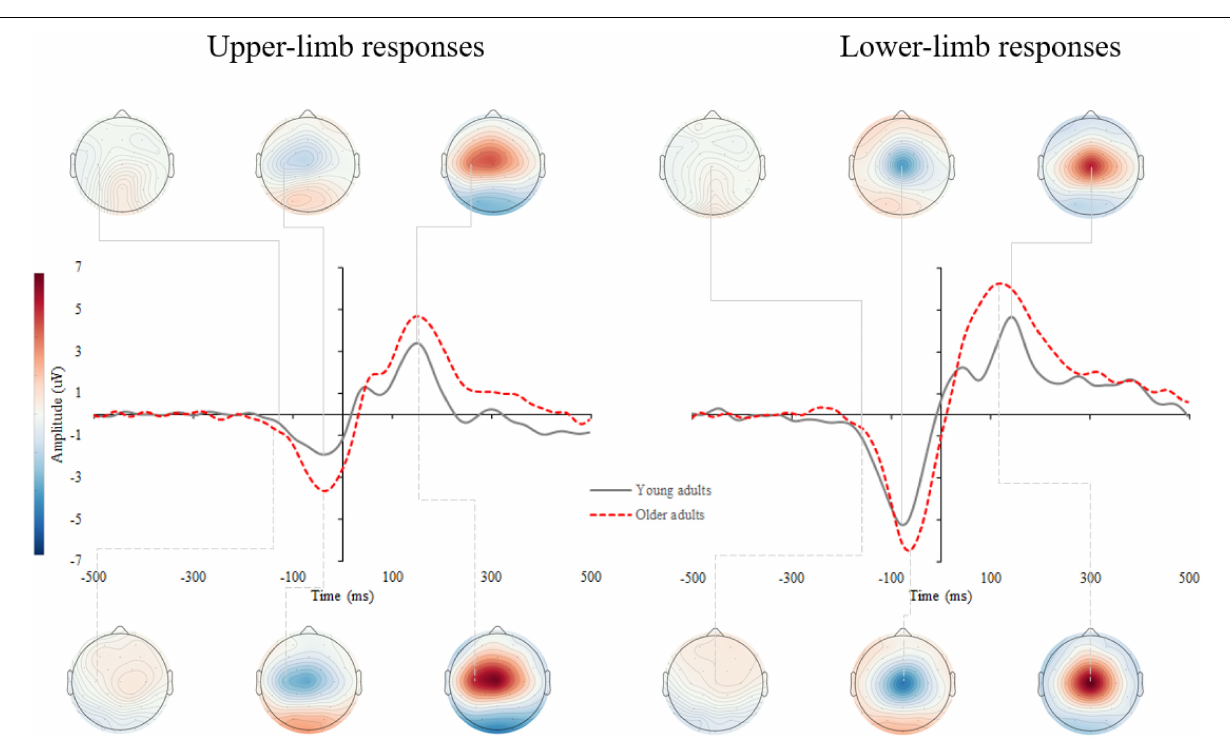
condition [ F (1,42) = 16.446, p < 0.001, Partial η 2 = 0.586], while the interaction effect was not significant ( p =